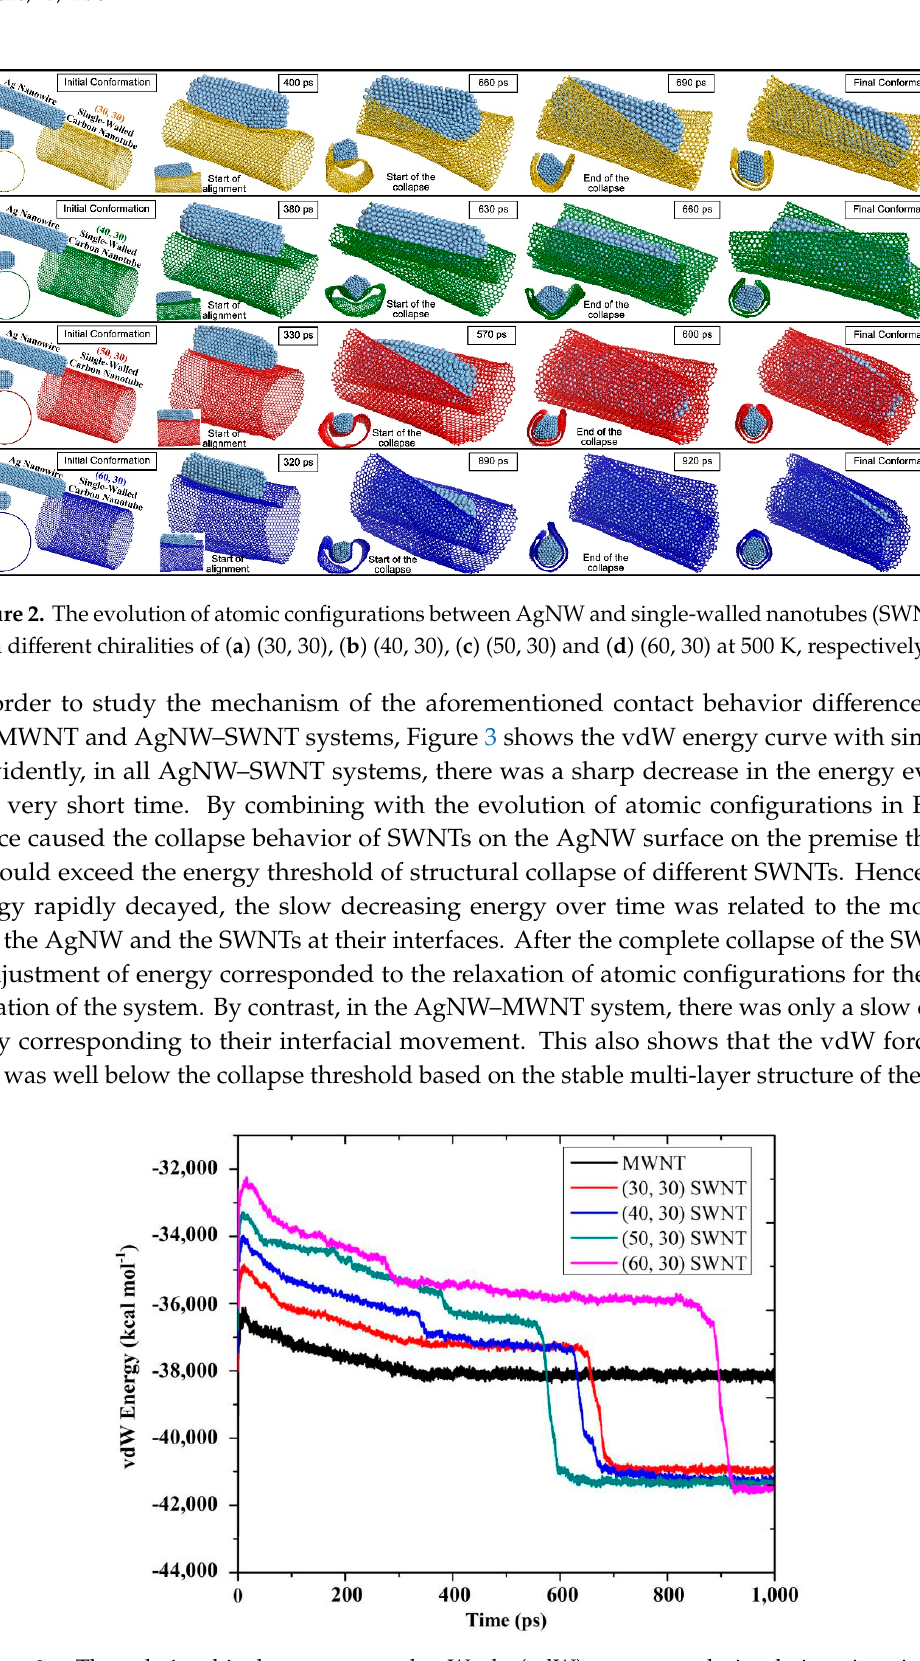
Figure 4. The relationship between vdW energy and simulation in ( a ) a large-diameter AgNW– DWNT (double-walled carbon nanotube) and ( b ) small-diameter AgNW–DWNT systems with illustrated atomic configurations in different times at 500 K. 4. Conclusions In this study, the interfacial contact behavior at an CNT–AgNW interface was investigated with MD simulations. The AgNW and CNTs were able to move towards each other to form an aligned hybrid structure. In the AgNW–MWNT systems, nanotubes maintained their inherent concentric cylindrical structure, while in the AgNW–SWNT systems, SWNTs were prone to completely collapse into nanoribbons that could tightly scroll on the AgNW periphery, wrapping it to form core-shell structures. As analyzed, the interfacial contact behavior was seriously affected by vdW energy, as well as the collapse threshold of the CNTs. Hopefully, this study can provide an understanding of AgNW–CNT interfacial behavior and guidance for future applications, such as nanomotors, heterogeneous catalysis, and composites.